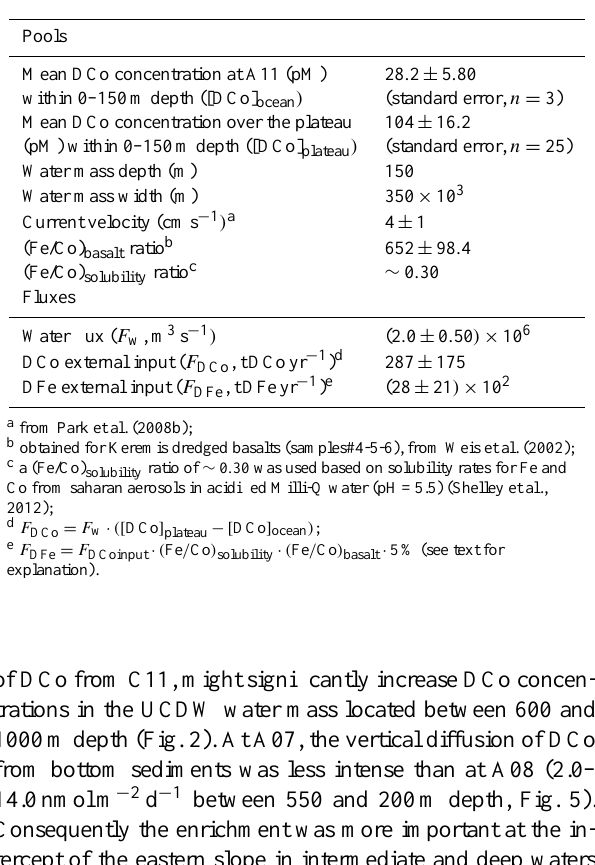
Table 2. Terms to calculate the external inputs of dissolved Co and Fe to the surface waters of the Kerguelen